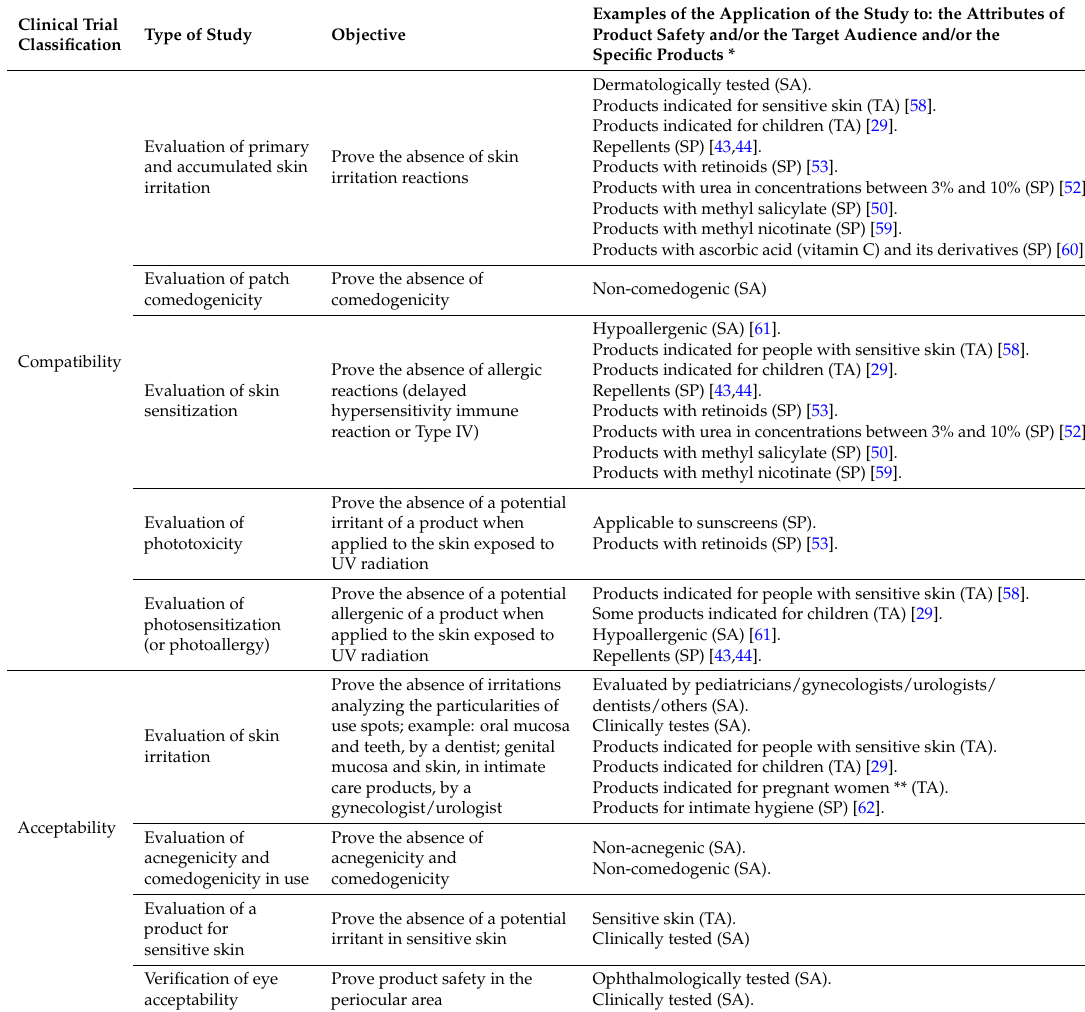
Table 9. Types and objectives of the compatibility and acceptance clinical trials related to the application of the study [26]. Clinical Trial Type of Study Classification